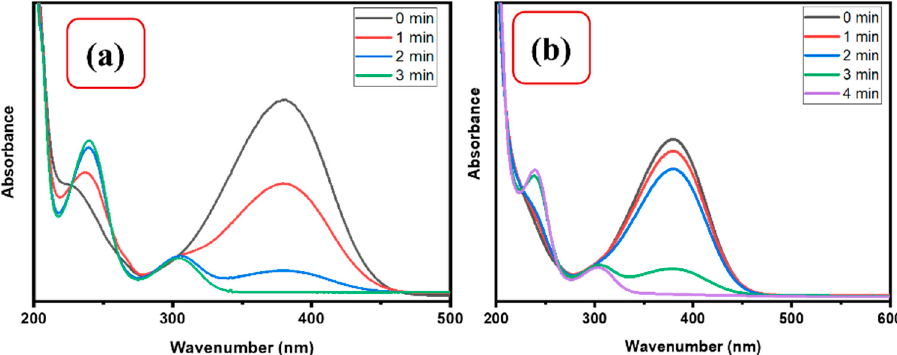
Figure 8. UV–Vis spectra for 0.13 mM 4-NP in the presence of ( a ) 0.5 M and ( b ) 0.1 M NaBH 4 using 5 mg CMC/CuO-TiO 2 .